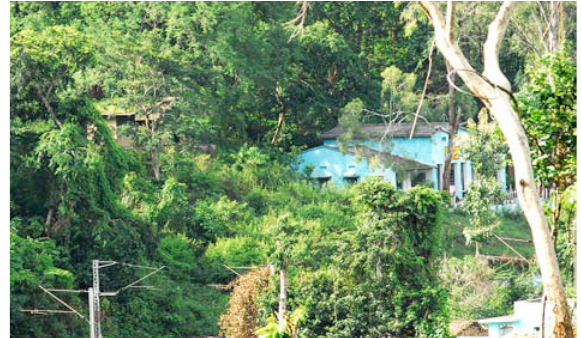
Image 2. Tyda railway station, one of the collection sites of Hemidactylus cf. frenatus.